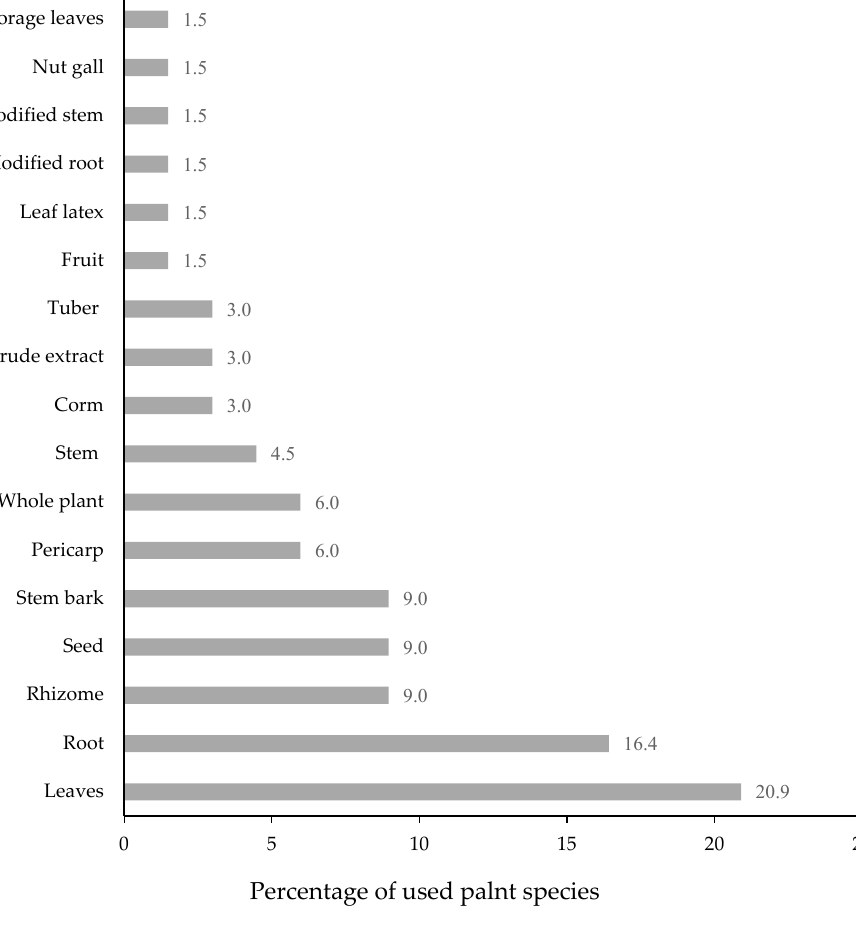
Figure 4. Plant part used in herbal remedies for skin diseases ( n = 66).